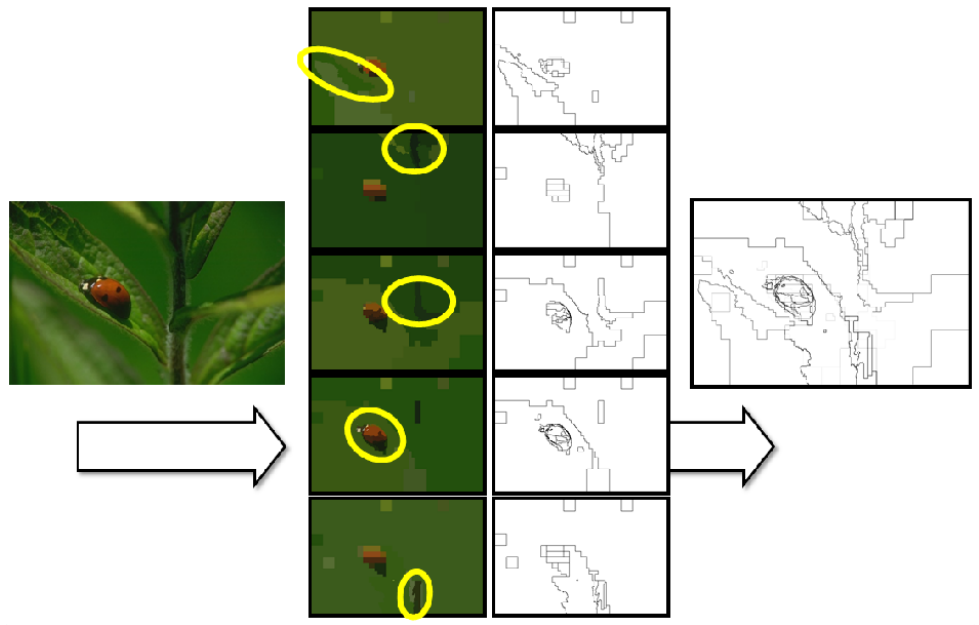
Figure 13. Obtaining the contour map associated with an input image as a combination of five foveations.